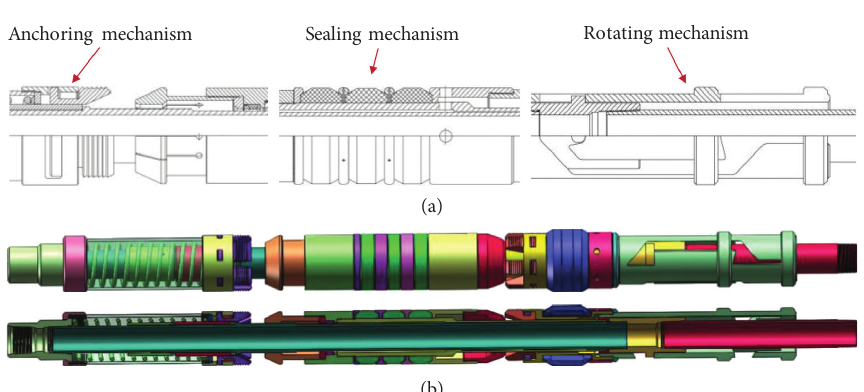
Figure 3: Structural schematic diagram of the retrievable packer of high temperature and high pressure. (a) Two-dimensional assembly diagram of retrievable packers. (b) Three-dimensional assembly of retrievable packers.